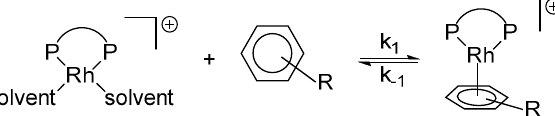
Figure 13. Molecular structure of the cation [Rh( S , S , R , R )-Tangphos)( η 6 -benzene)] + , left, and of the cation [Rh(DPPF)( 2 , 6 -dimethyl- η 6 -aniline)] + , right. Hydrogen atoms are omitted for clarity.